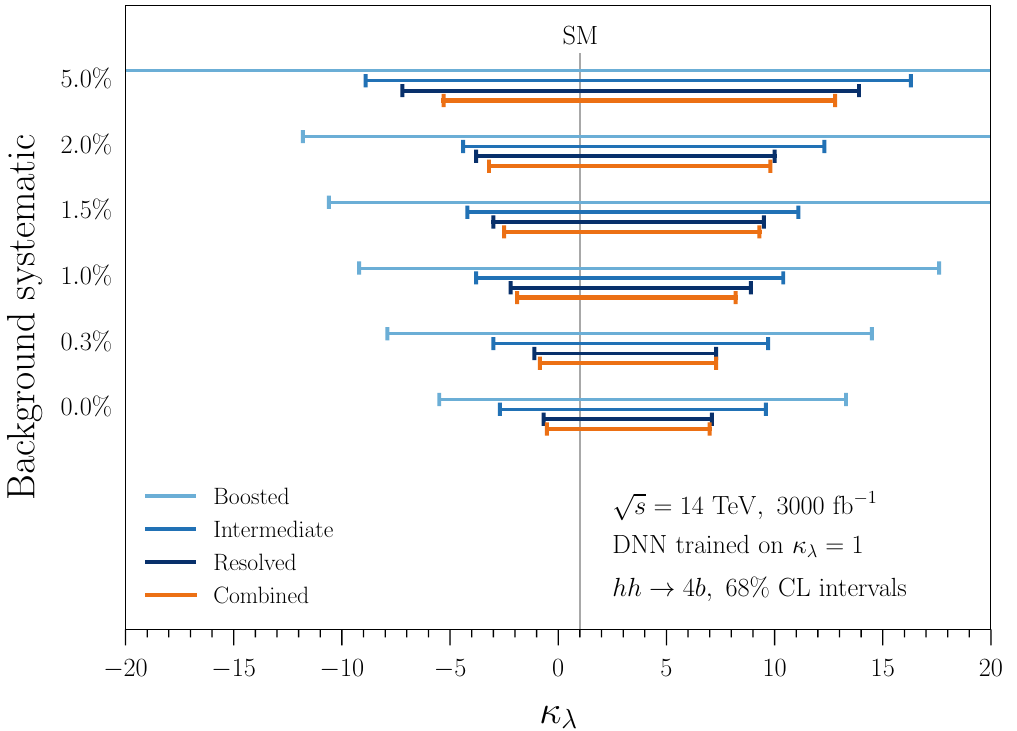
Figure 26. Discrimination power χ 2 (higher is better) between two self-coupling values κ i ij κ j . This is displayed for the (a) baseline and (b) neural network trained on κ λ = 1 analyses. The λ requirement on the signal score p signal > 0 . 75 is imposed for the DNN. The χ 2 eq. (3.1). This assumes κ t = 1 . 0 and background systematics of ζ b = 0 . 3% , 1% and 5% for the resolved, intermediate and boosted categories, respectively.